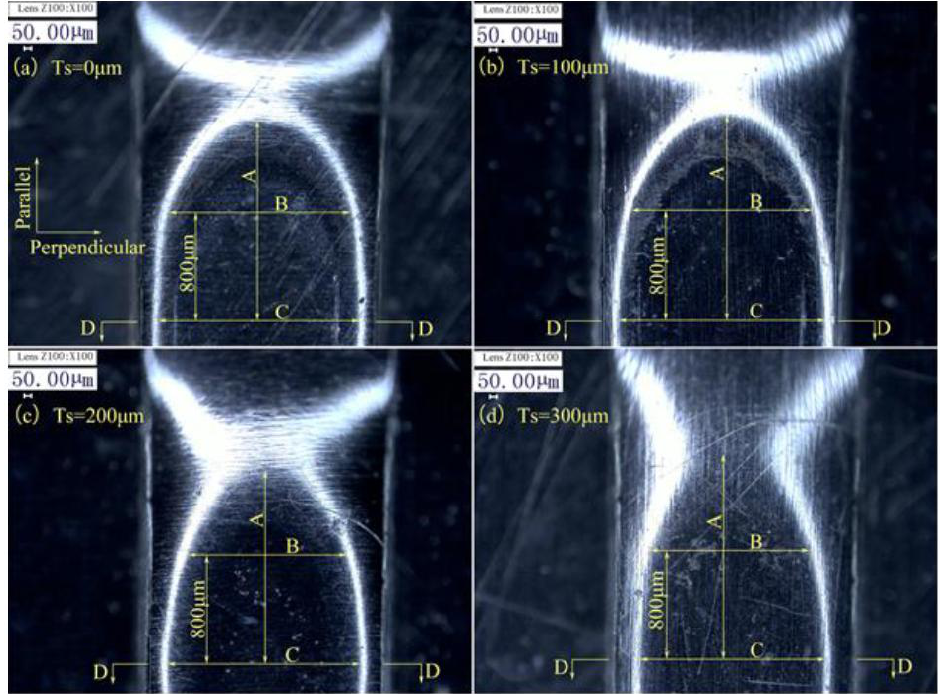
Figure 4. Lower foil side-view of the preliminary joints with four different soft punch thicknesses: ( a ) Ts = 0 µ m; ( b ) Ts = 100 µ m; ( c ) Ts = 200 µ m; ( d ) Ts = 300 µ m.